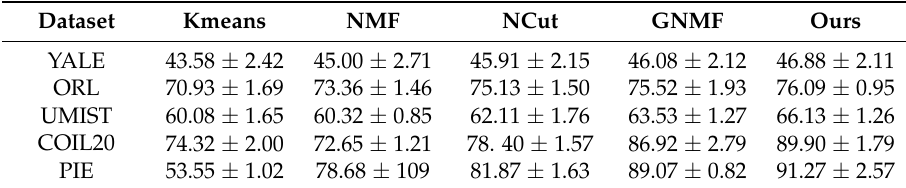
Table 3. Normalized Mutual Information on the 5 datasets